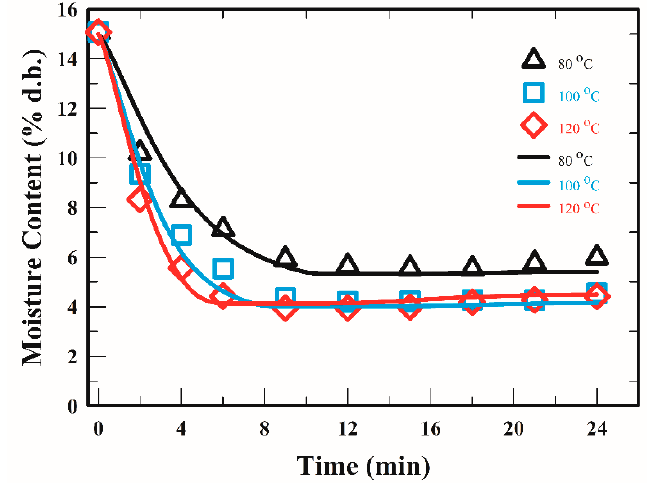
Figure 3. Profiles of the moisture content of wheat germ during drying in the FBD at different set temperature. The symbols represent the experimental data; the lines represent the simulated values.